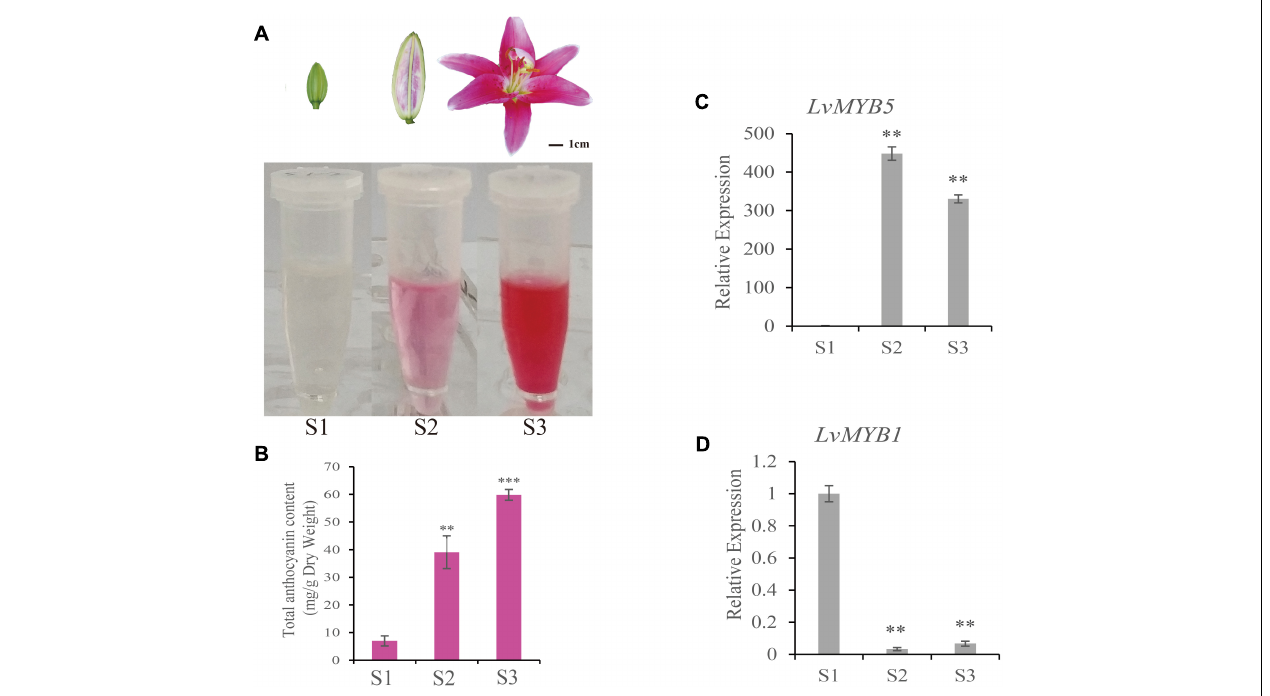
FIGURE 1 | Determination of anthocyanin content and LvMYB5 and LvMYB1 expression analysis in lily petals during lily flower development. (A) Extraction of anthocyanins from lily petals at three different developmental stages (S1, S2, and S3). (B) Quantification of anthocyanin contents in lily petals at developmental stages S1, S2, and S3. (C,D) Relative gene expression levels of LvMYB5 (C) and LvMYB1 (D) at stages S1, S2, and S3. Data are means ( ± SD) of three biological replicates per variety ( ∗∗ p ≤ 0.05, ∗∗∗ p ≤ 0.01).